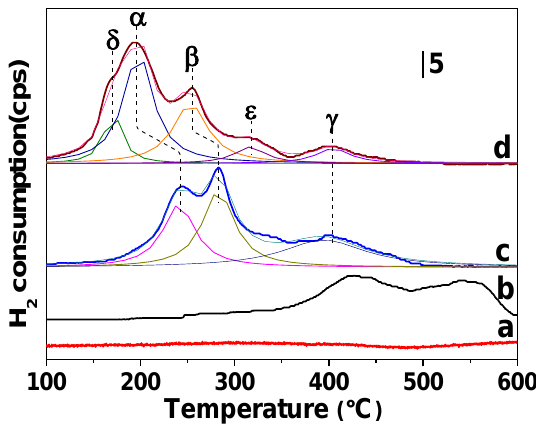
Figure 5. Temperature-programmed reduction by hydrogen (H 2 -TPR) profiles of ( a ) ZrO 2 , ( b ) CeO 2 , ( c ) Cu/ZSM-5 and ( d ) CuCe 0.75 Zr 0.25 /ZSM-5.